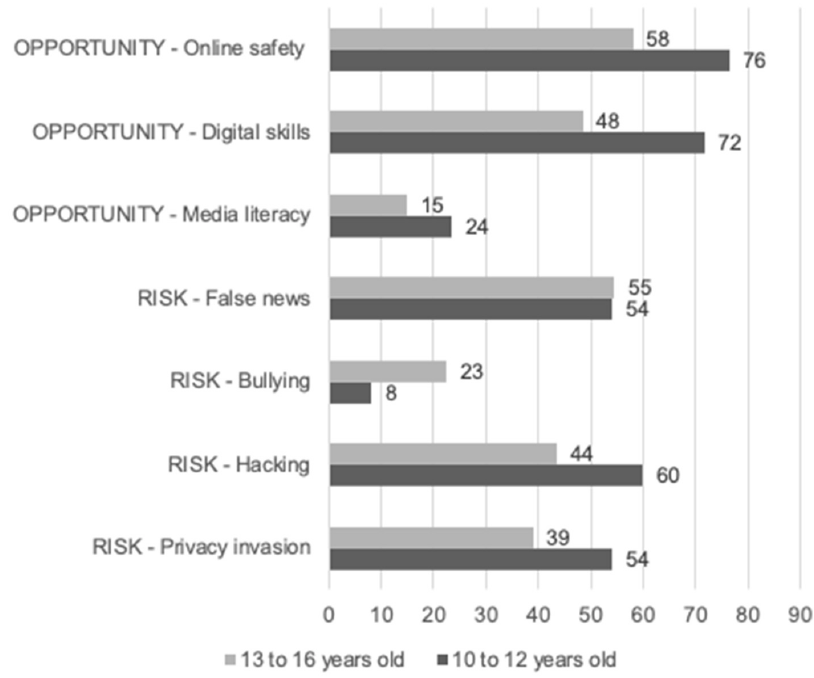
Figure 10. TikTok users who agree with expressions concerning the risks and opportunities of the platform, by age (in percentage).